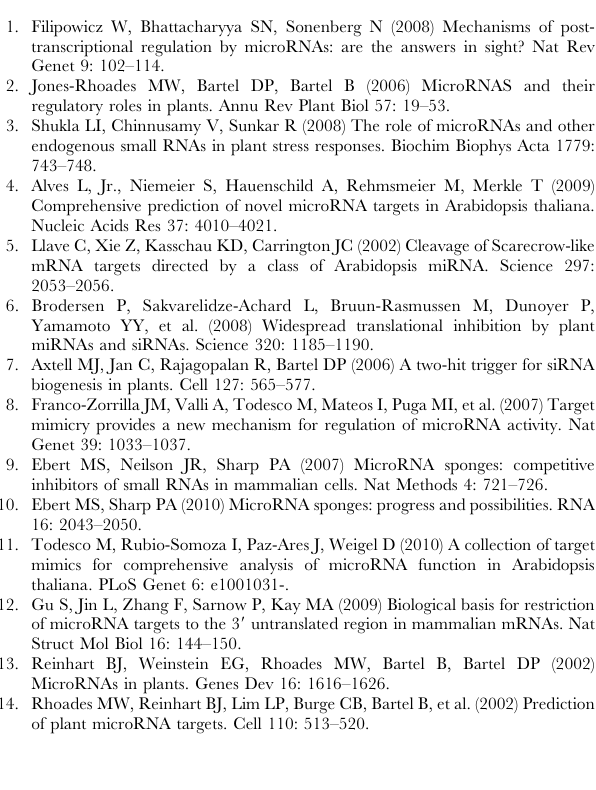
test Results from ANOVA. Results are from comparison of each event (homozygous (ho) or hemizygous (he)) versus the wild type control within each tissue, and adjusted p-values were computed from Dunnett’s test. Table S3 Statistical analysis of qRT-PCR expression data of SCL6-III (At3g606030) in miR171_3B transgenic decoy events versus miR171_2M transgenic decoy events. Two-sized T-test results from ANOVA. Results are from comparison of two constructs within each tissue type. No adjustments were done to the raw p-values. Table S4 Predicted endogenous miRNA decoy sites in Arabidopsis thaliana. For each unique miRNA sequence, the columns are miRNA ID (random if multiple loci encodes the same sequence), sequence (5 9 – 3 9 ), and all other miRNA IDs if they share the same sequence. For each predicted decoy, there are three rows listing (1) the query miRNA sequence (3 9 – 5 9 ),